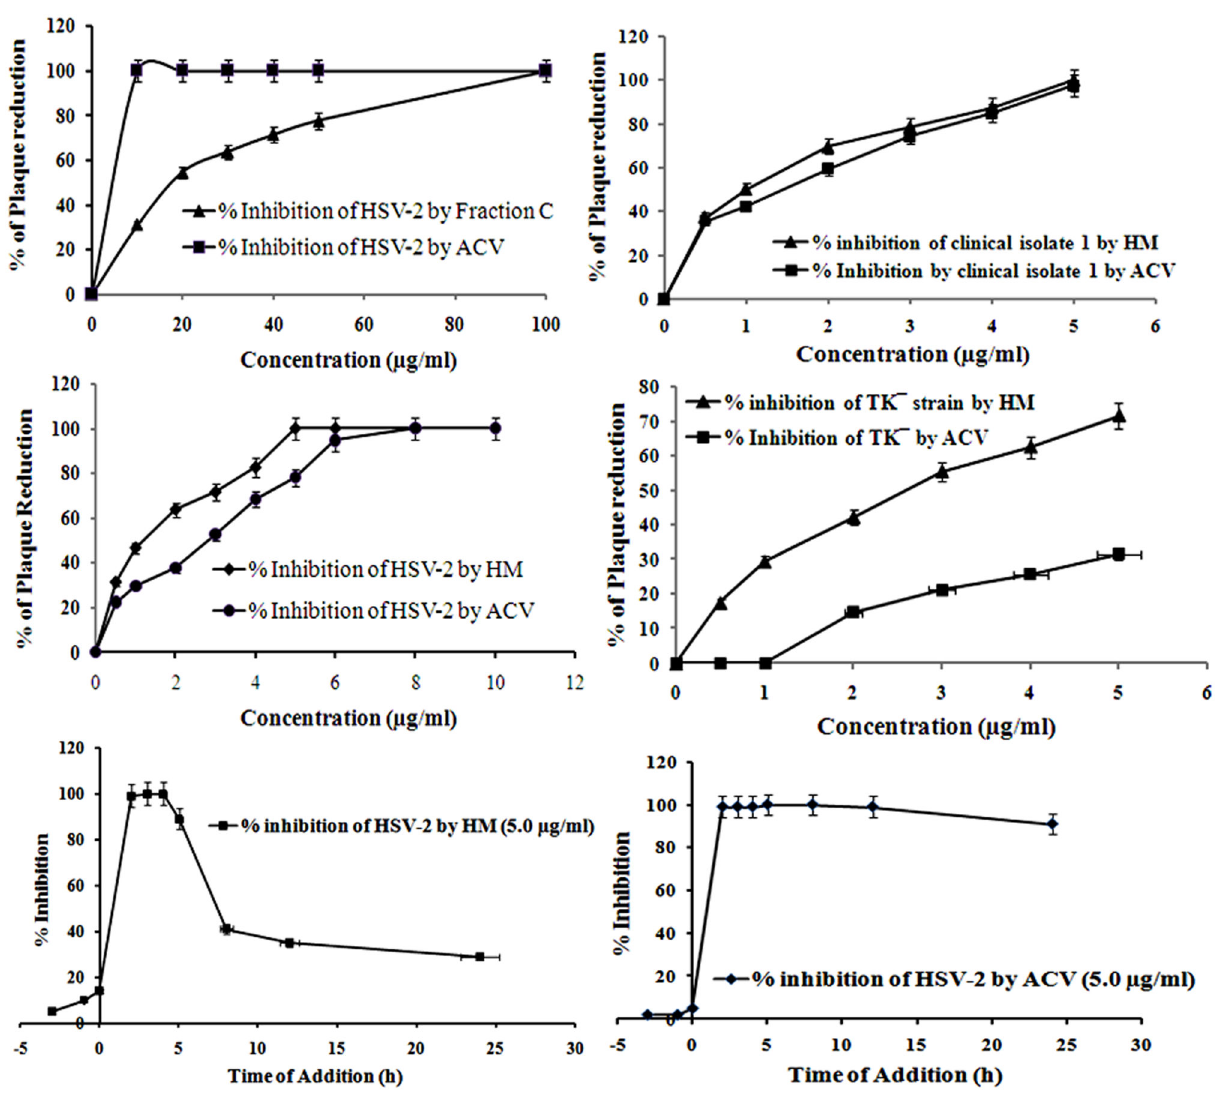
Figure 1. Anti-HSV efficacy of HM. [A] Plaque Reduction Assay . Infected cells were treated with HM or ACV at 0.5-50 μg/ml, overlaid with methylcellulose and plaques developed after 2-3 days were stained. The % of plaque number reduction was calculated, and the effective concentration of drug that inhibited the number of viral plaques was interpolated from the dose- response curve. [B] Time course analysis . Inhibitory effects of HM and ACV at various time points prior to infection (-3 to -1 h), at the time of infection (0 h) and post-infection (2-24 h) with HSV-2 were evaluated by plaque reduction assay. Each bar represents the mean ± S.E.M of three independent